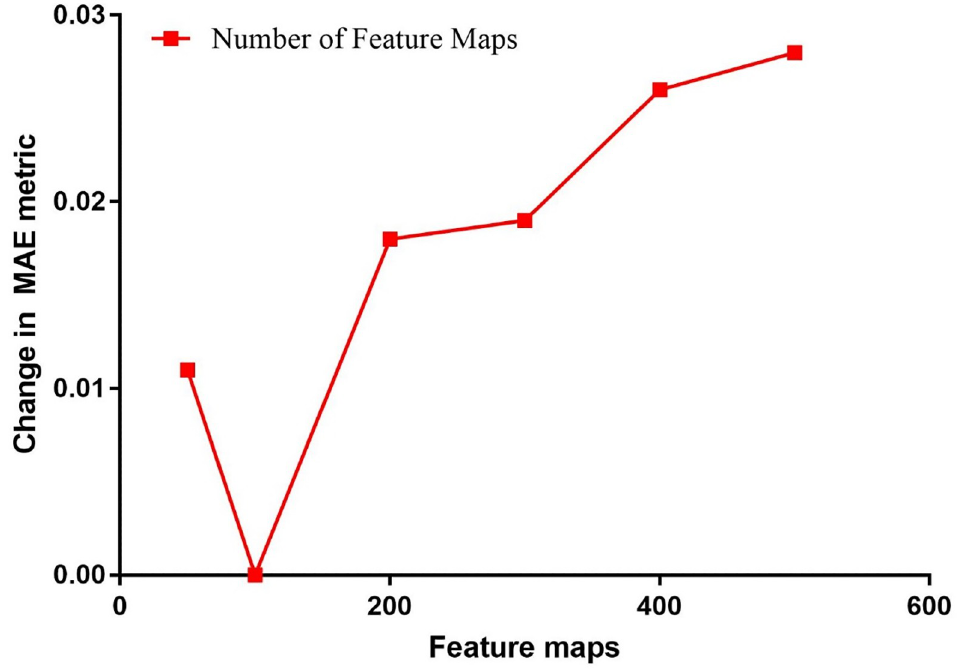
Fig 5. Effect of the number of feature maps measured using change in